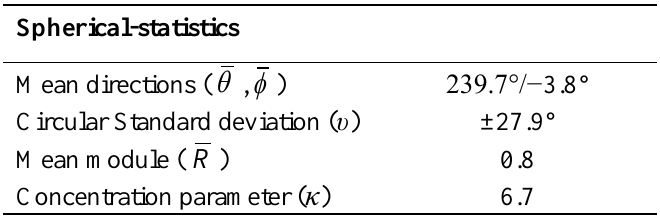
Table 3. Spherical statistics results for angular error analysis.